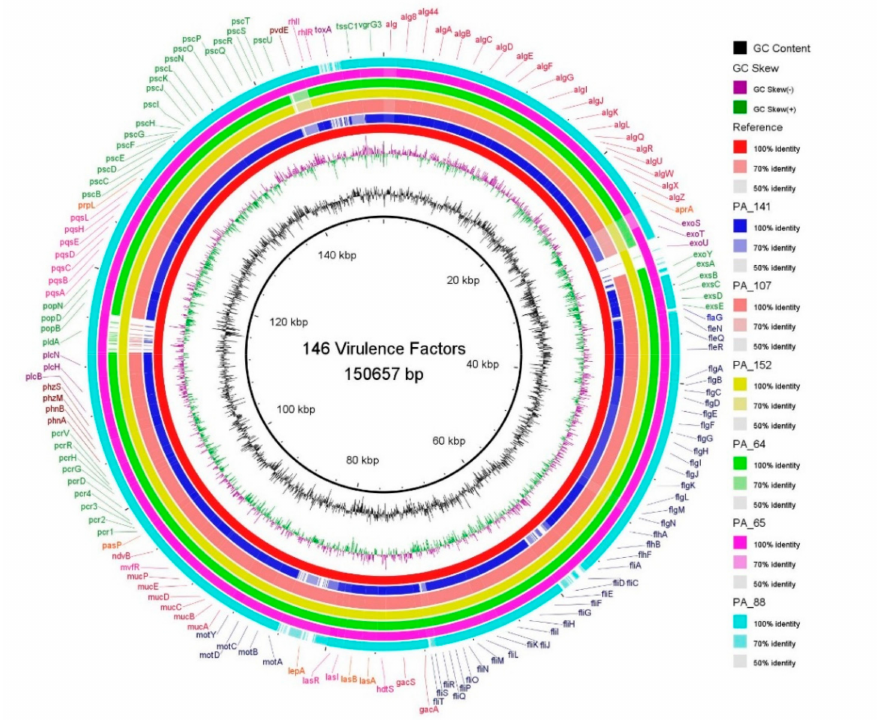
Figure 2. A circular representation of the genomes of studied isolates. The draft genomes were aligned against 146 virulence genes of reference strains (PAO1, UCBPP-PA14) curated from VFDB. Each genome is represented by a ring with different colors. The color coding indicates the percent identity of the virulence gene in studied genomes to reference sequence. Image was generated using BRIG